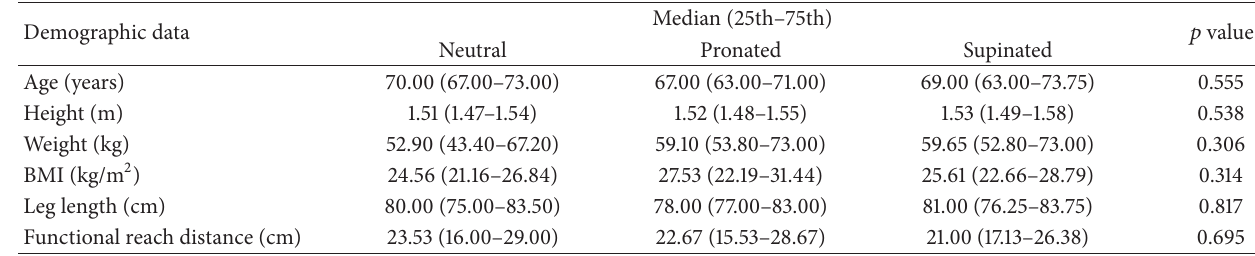
Table 1: Characteristic of the participants ( 𝑁 = 50 ).